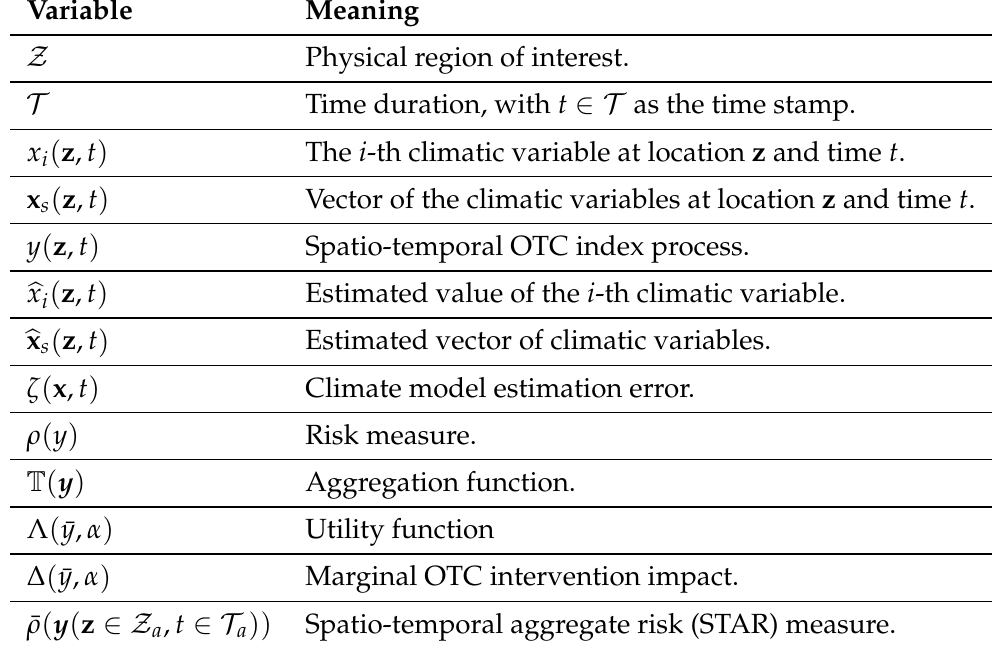
Table 1. Table of